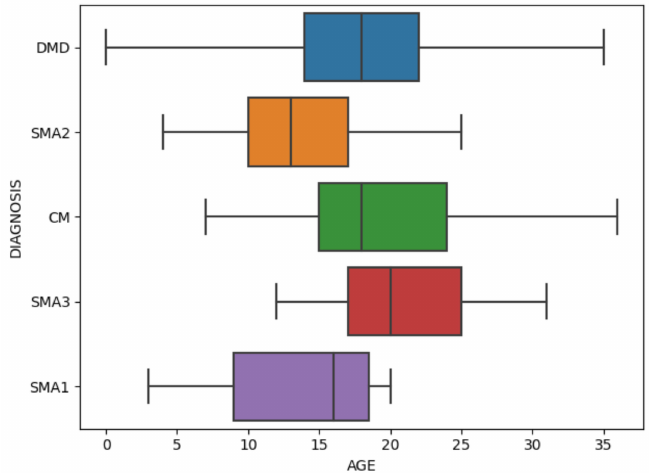
Figure 7. Box plot of age distribution.